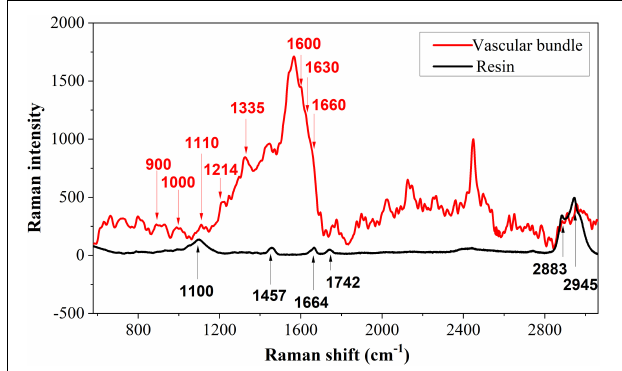
FIGURE 5 | A typical Raman spectrum of the vascular tissue and the spurr